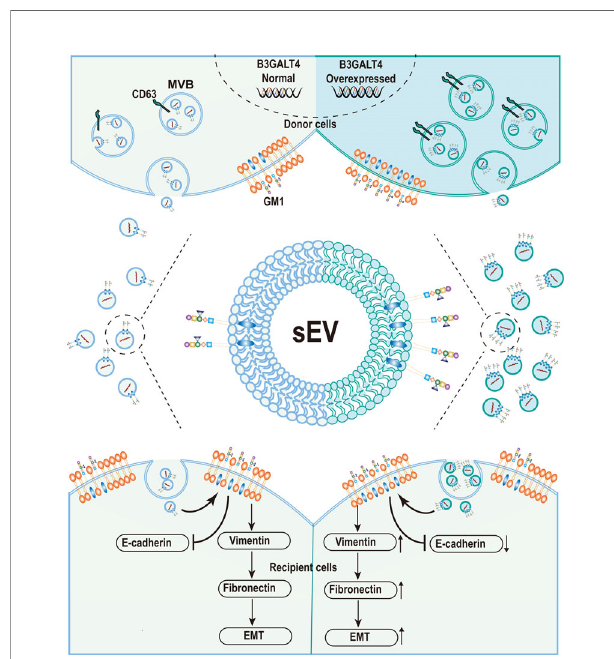
FIGURE 6 | Graphical Abstract. The schematic model of ganglioside GM1 mediating the epithelial – mesenchymal process of breast epithelial cells via tumor-derived small extracellular